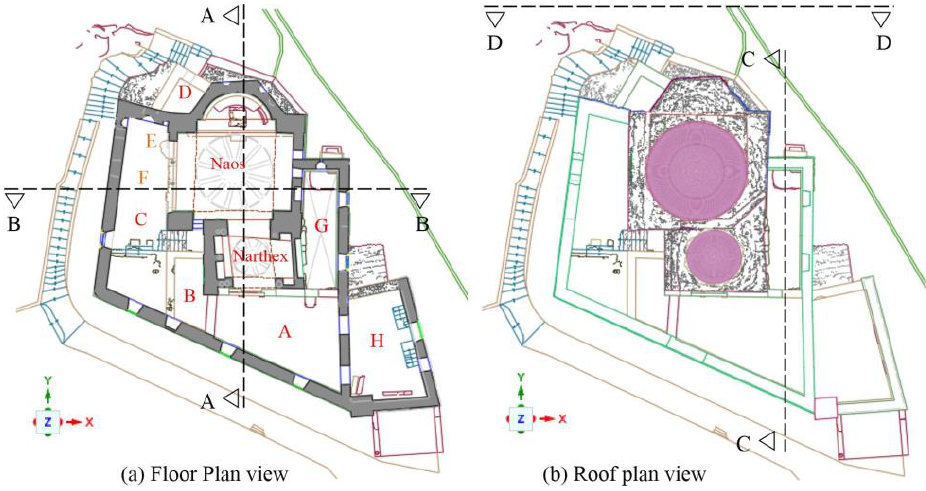
Figure 2. Floor and roof plan views of the structure [41].